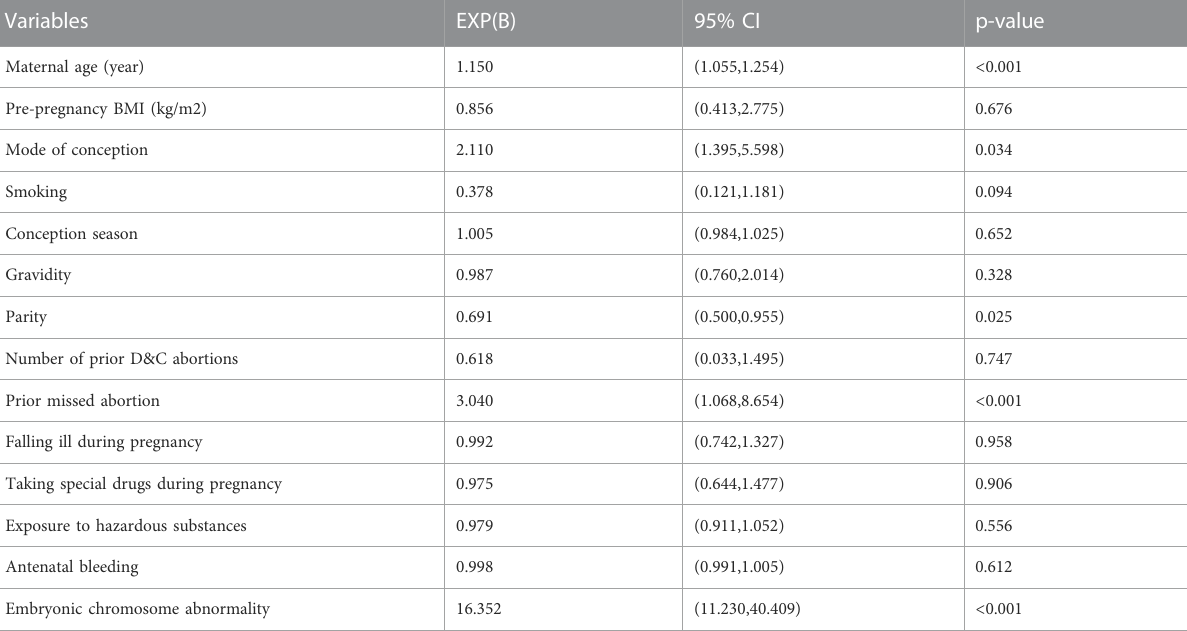
TABLE 4 Association between the maternal covariates and missed abortion.